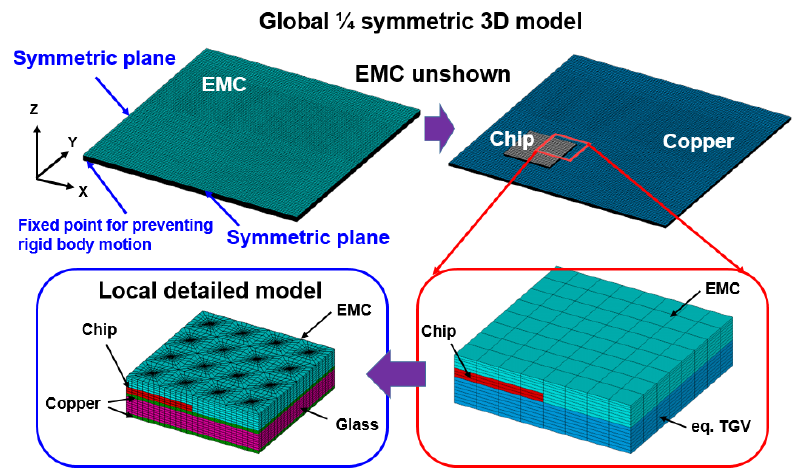
Figure 4. Flow chart diagram of the present submodeling simulation approach with the global in- terposer architecture model and local region model.